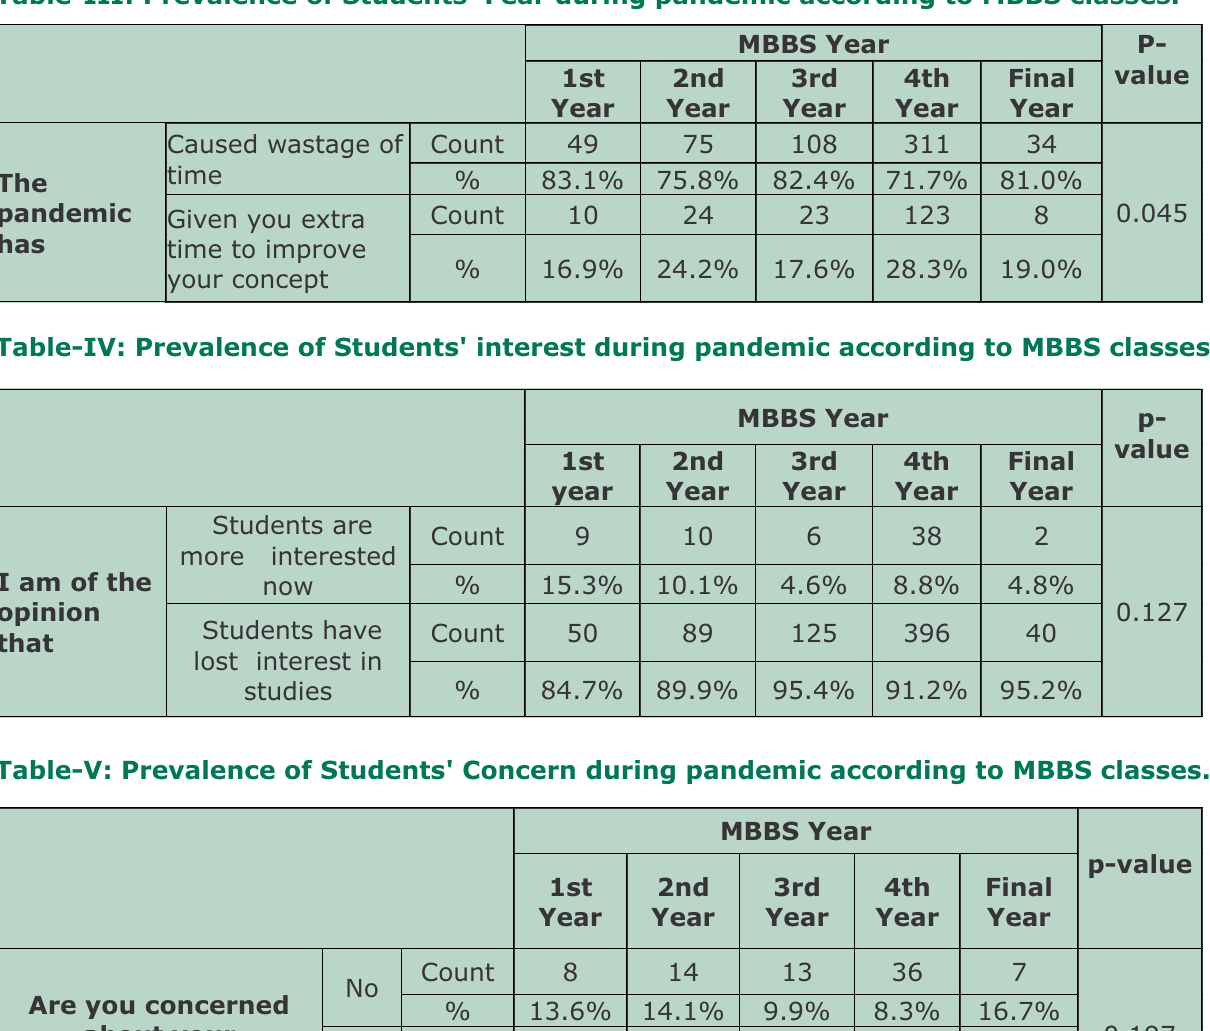
Table-III: Prevalence of Students' Fear during pandemic according to MBBS classes.